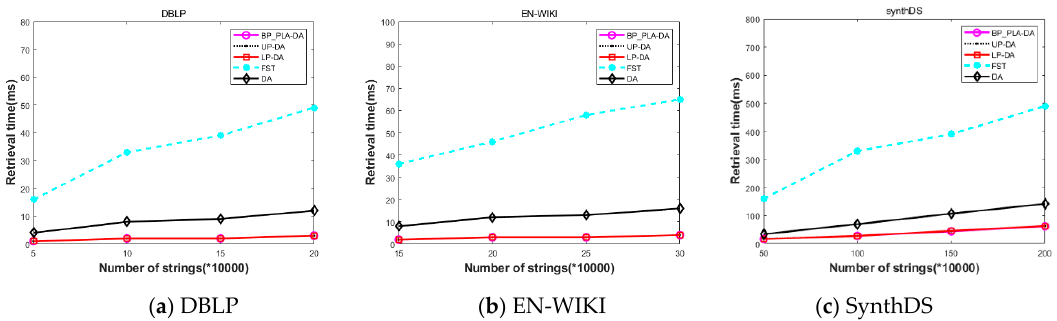
Figure 10. Construction times for different number of strings.